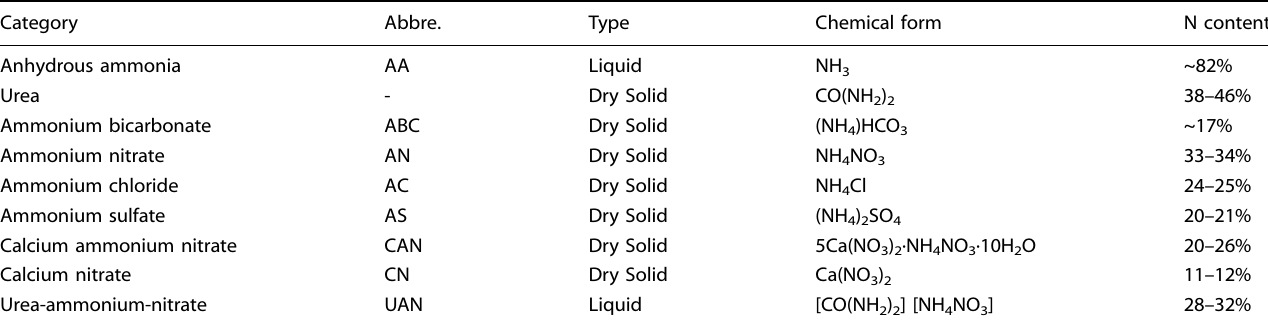
Table 2. Type of fertilizers with their associated basic